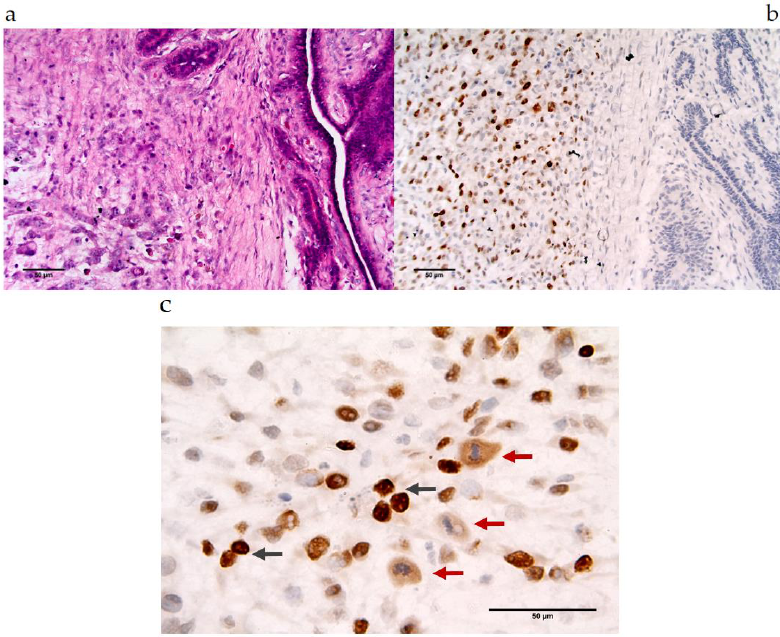
Figure 3 . Positive cross - reactivity of MAb 6C1, mammary gland tumors and canines . Location of